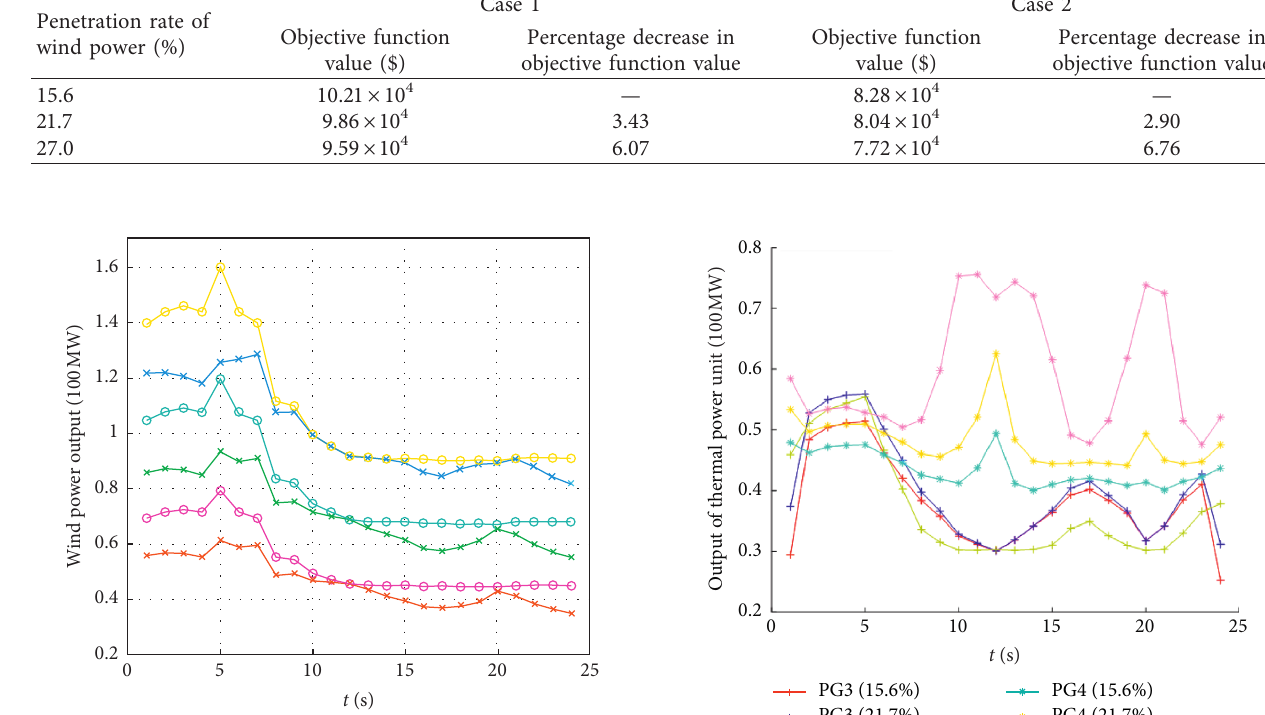
Table 1: Comparison of objective function value in two cases under different wind power penetration. Penetration rate of